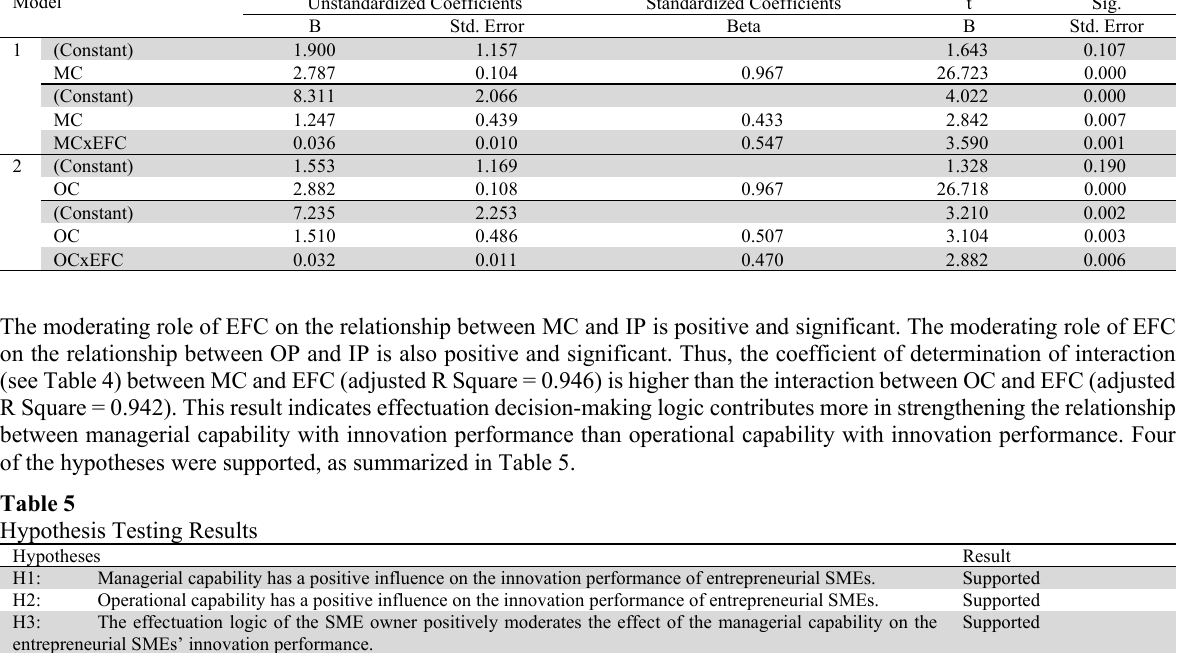
The results of regression analysis Model